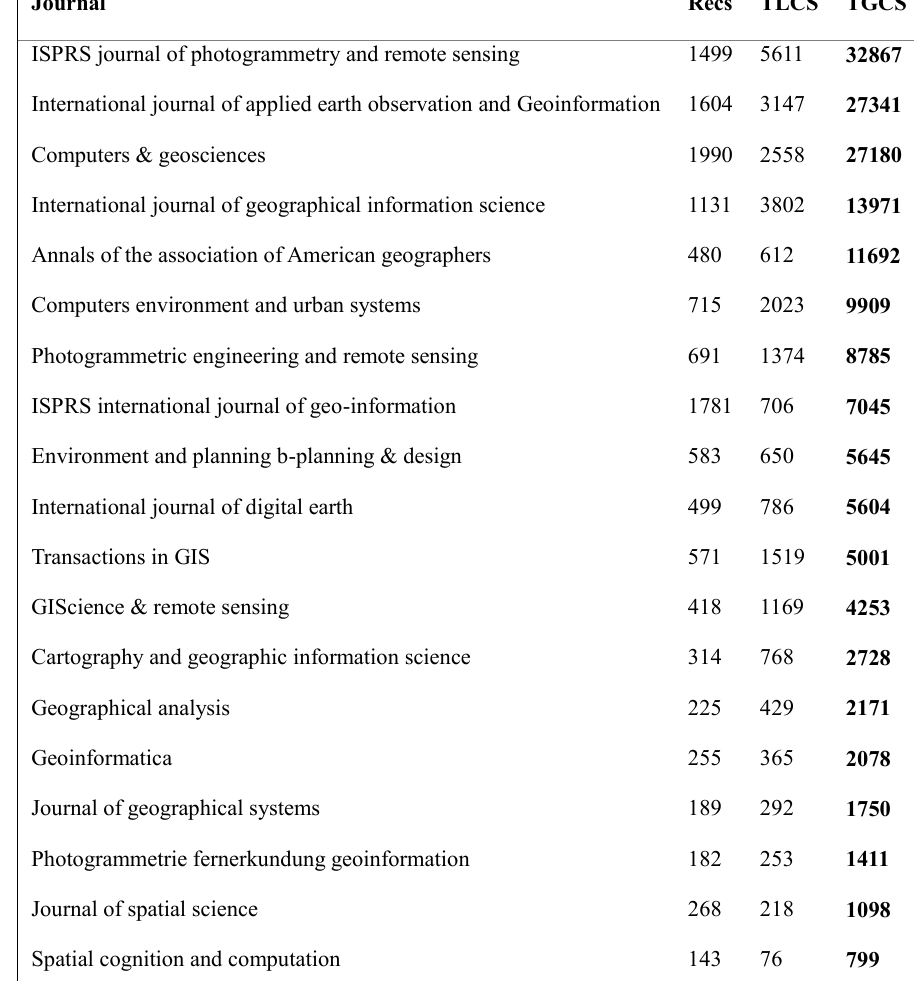
Table 2. Journals ranked in out-domain